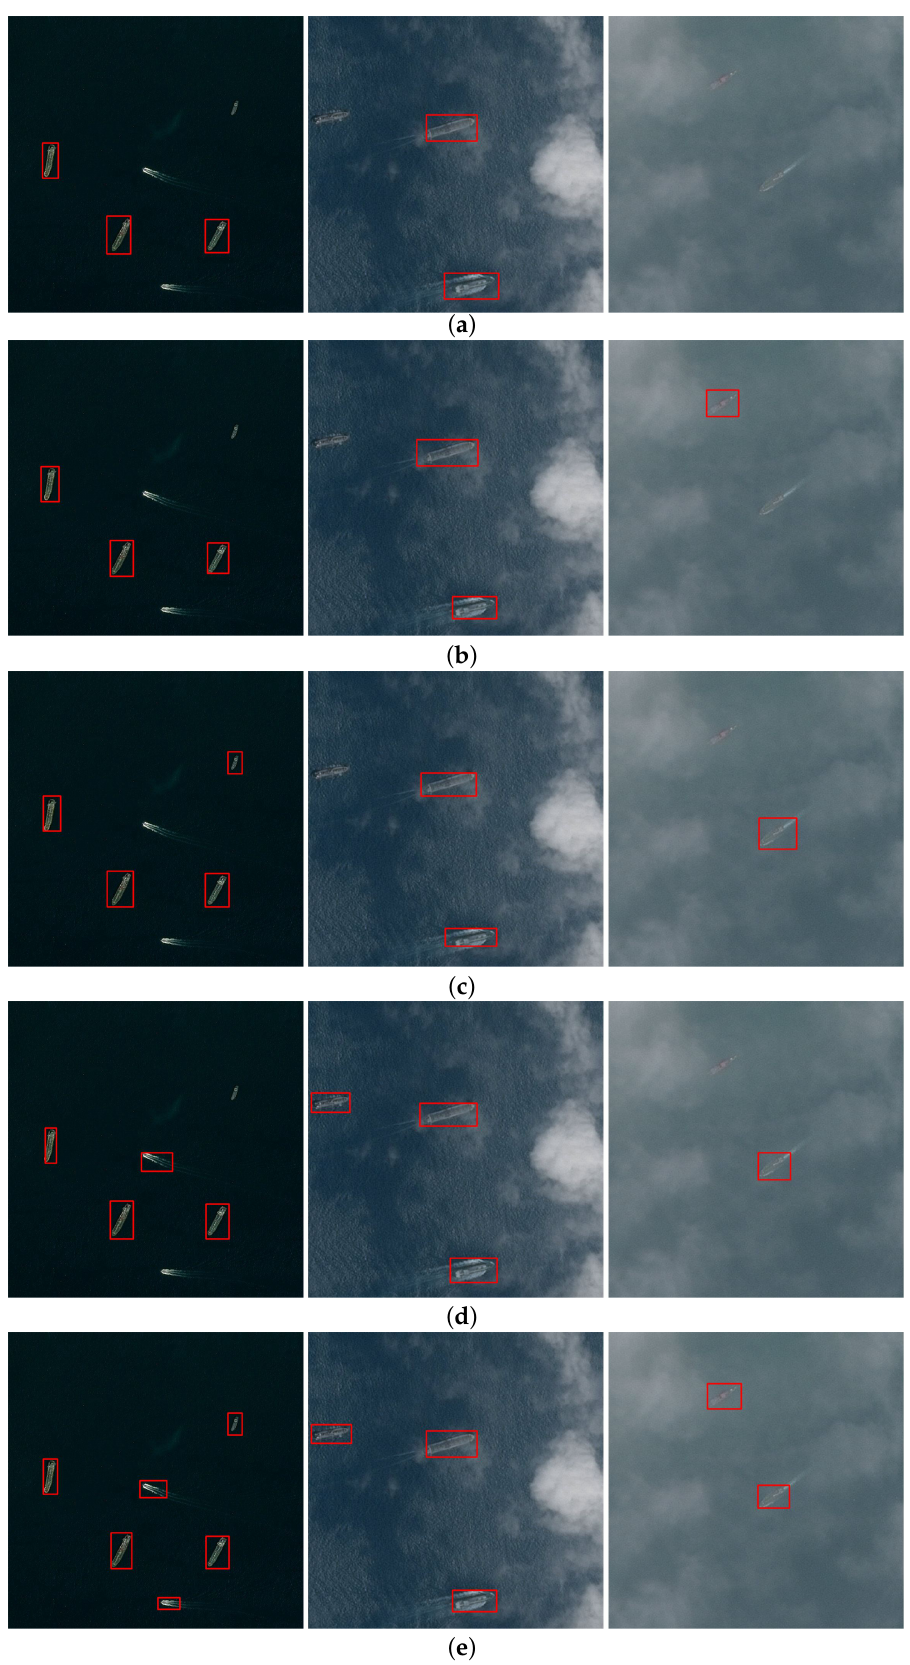
Figure 12. Comparison of the ship-detection results by different methods on the Airbus